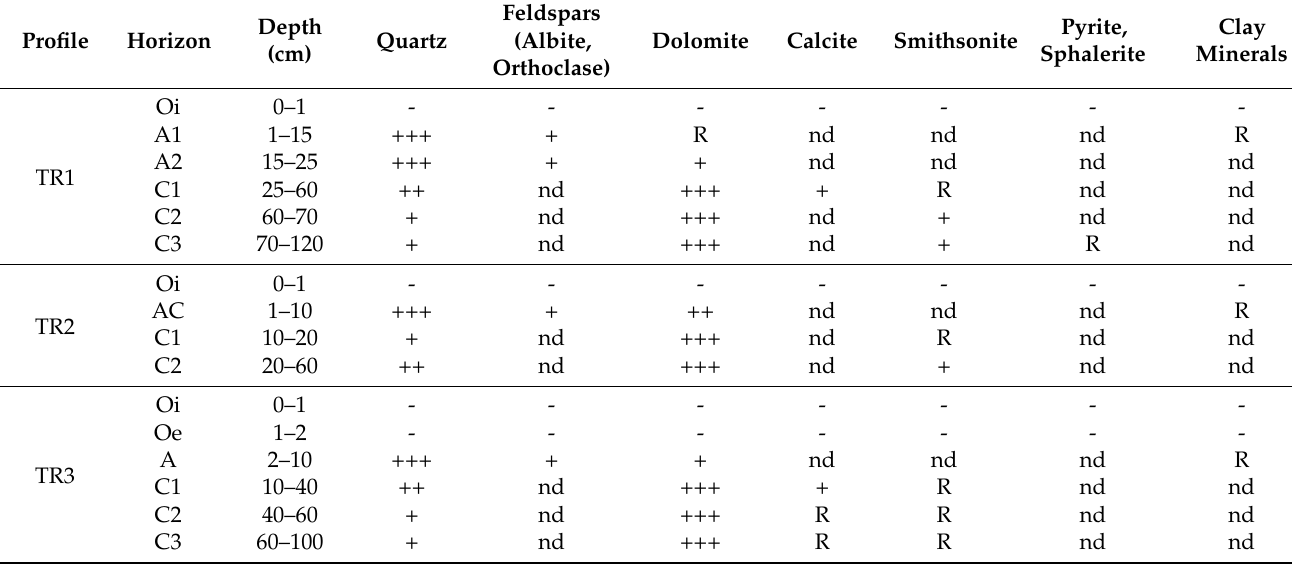
Table 4. Mineral composition of the studied soil samples based on powder XRD analyses. Minerals are arranged in a semiquantitative order based on the relation of peak intensities in the XRD patterns (the most abundant minerals are labelled as +++, and the least abundant ones as +; R—refractory minerals, nd—the minerals which were not detected using powder XRD analysis, -: not